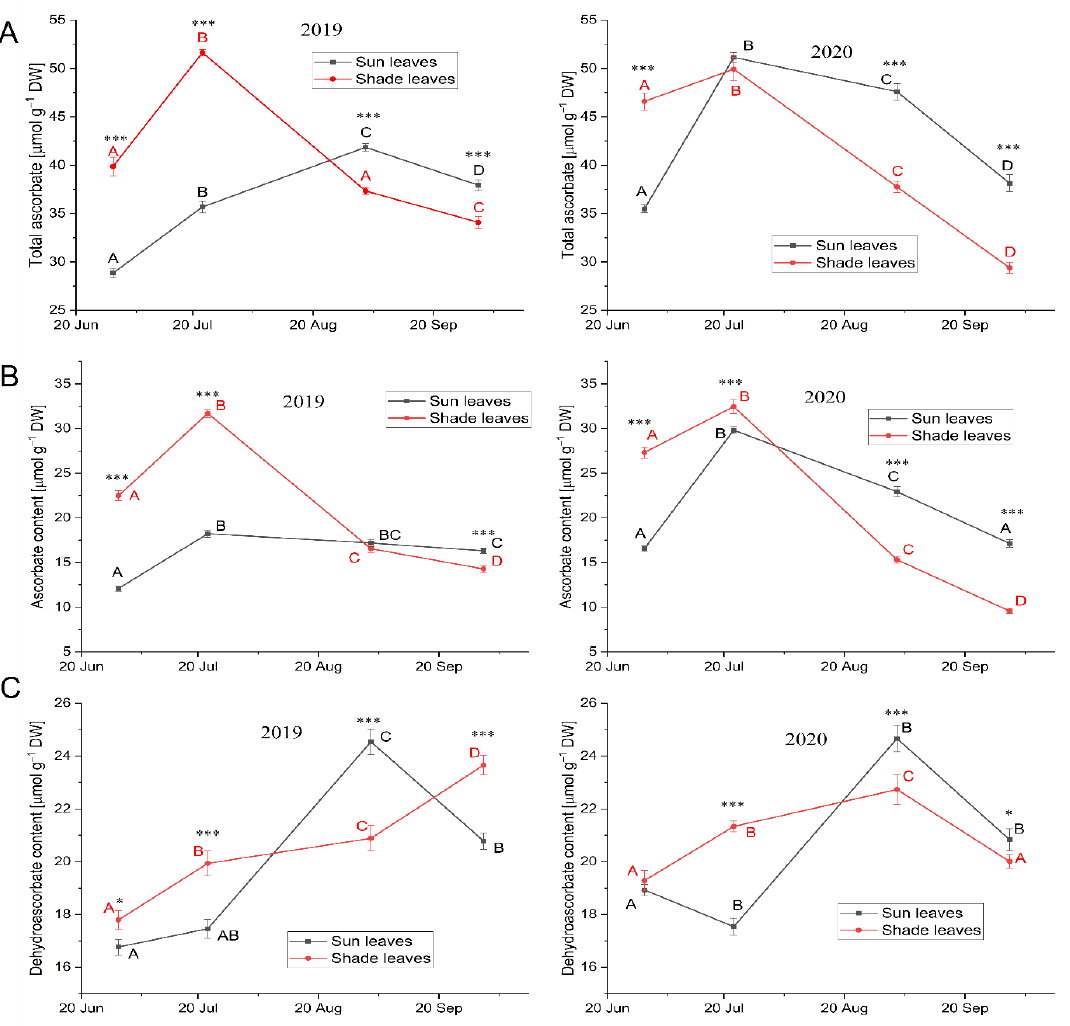
Figure 5. Changes in total ascorbate ( A ), ascorbate ( B ), and dehydroascorbate ( C ) contents in the sun and shade senescing beech ( Fagus sylvatica L.) leaves. Analyses were performed for sun (black line) and shade (red line) leaves in 2019 and 2020. Each point is the mean of 60 measurements (±standard error). For each type of leaves, means with different uppercase letters differ significantly at p < 0.05. For each date, means with asterisks differ significantly at * — p < 0.05, and *** — p < 0.001. Compared with shade leaves, the total content of reduced and oxidized forms of glu- tathione was significantly higher in the sun leaves regardless of the climatic conditions of both years. The maximum glutathione content in both sun and shade leaves was reached in early September, followed by a decrease after induction of senescence (Figure 6A). A